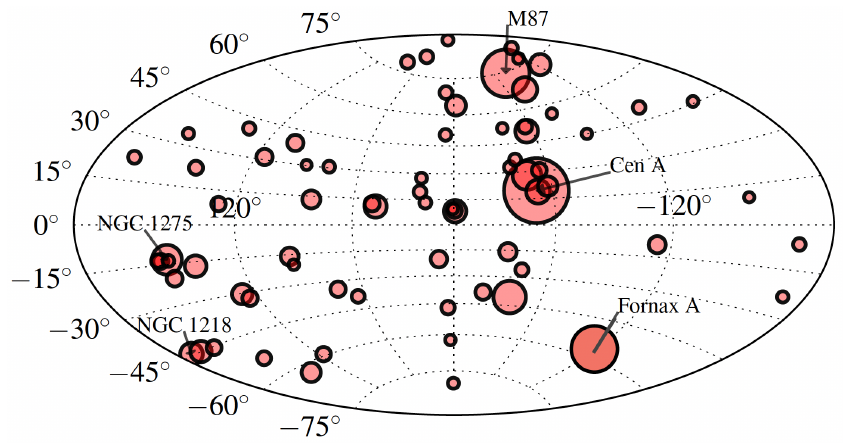
Figure 6. Map in Galactic coordinates of the 74 radio galaxies within ∼ 130 Mpc, along with the locations of some prominent (FR I) sources. The circular areas are proportional to the ∼ 1 GHz-radio flux of the source. Adapted (with Fornax A adjusted) based on ref. [48].